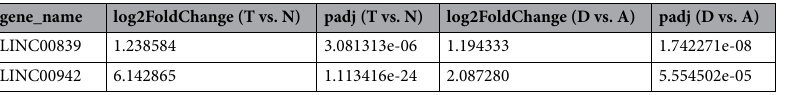
Table 2. Two lncRNAs overlapped in two sets. T versus N means different expression between liver cancer samples (n = 374) and normal samples (n = 50). D versus A means different expression between patients with OS.event dead (n = 130) and OS.event alive (n = 235). The log2FoldChange > 1 and padj < 0.001 were set as the threshold for significantly different